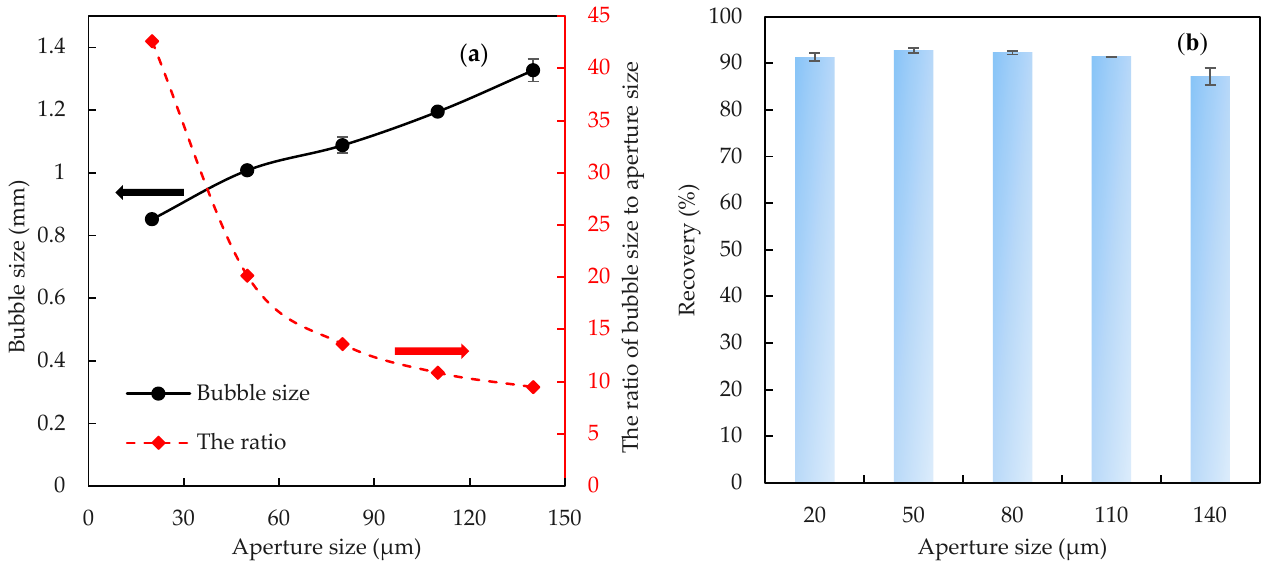
Figure 4. Effects of orifice size on bubble size ( a ) and flotation recovery ( b ) under oscillatory air supply. As can be seen from Figure 4a, bubble size increased with increasing the orifice size, which is consistent with literature [16,17]. It is interesting to note that the ratio of bubble size to orifice size decreased with the orifice size since the capillary resistance decreases over the orifice size [10]. Figure 4b shows that increasing the orifice size decreased the flotation recovery owing to increased bubble size, which falls the same trend compared to chamber volume and plate thickness.